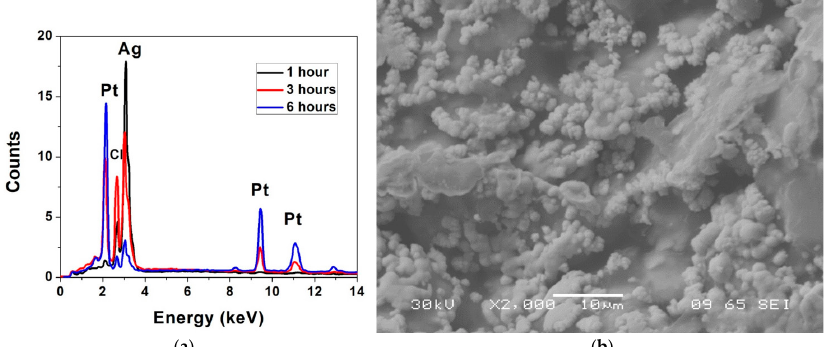
Figure 11. ( a ) EDS measurements confirm the presence of platinum and the coverage on the surface is observed to increase from 7% wt. to 31% wt. and finally to almost 95% wt. after 1 h, 3 h and 6 h of electroless deposition respectively; ( b ) SEM analysis of the electrodes showing micro-porous platinum deposited on the silver paste electrodes after 6 h of electroless deposition.